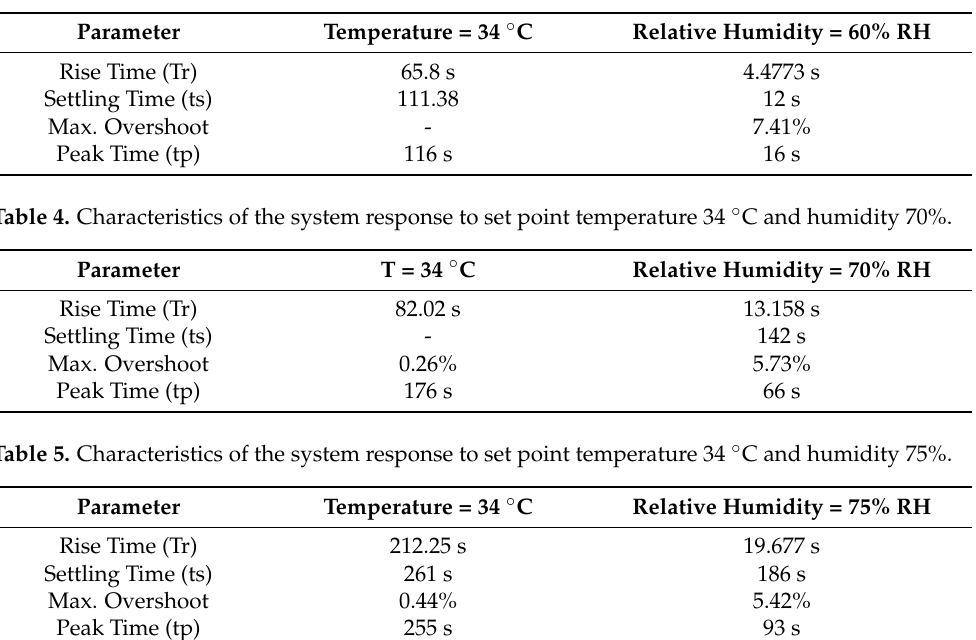
Table 3. Characteristics of the System response to the set point temperature 34 ◦ C and humidity 60%.